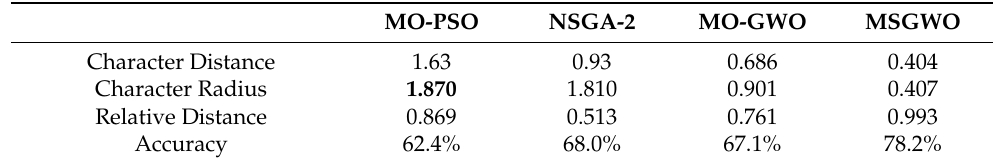
Table 2. Classification Results.